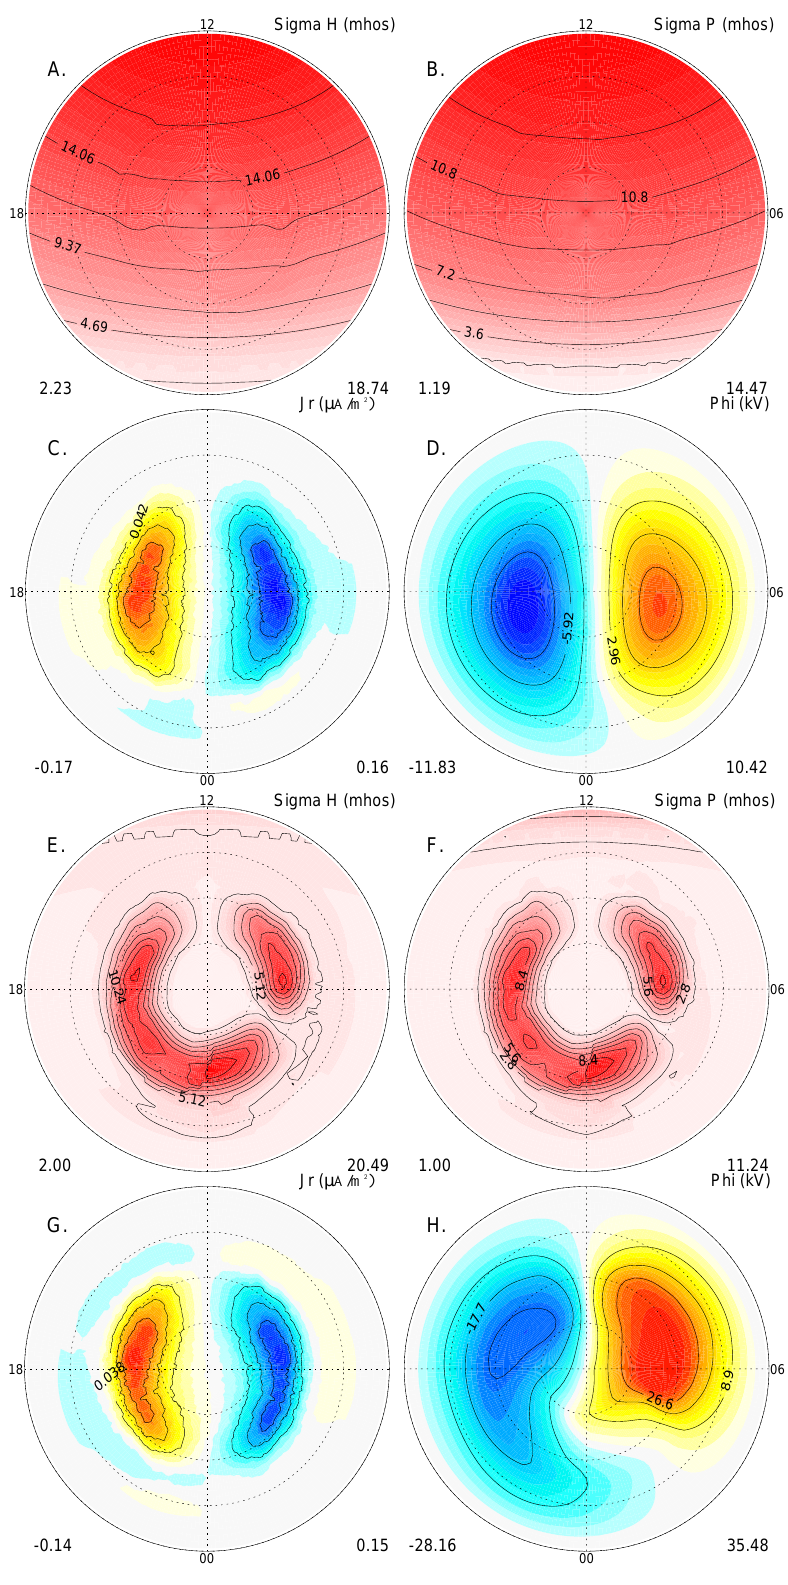
Plate 13. Ionospheric results for summer (A–D) and winter conditions (E–H) , for a similar time as Plate 8, but with an auroral oval, a background conductance of 1mho Pedersen, and a seasonal dependent polar cap conductance added. This figure is in the same format as Plate